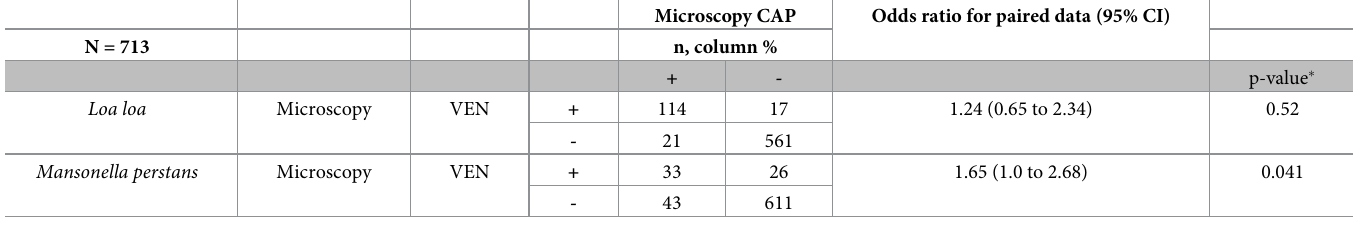
Table 4. Crosstabulation of capillary (CAP) and venous (VEN) microfilaraemia and odds ratios to quantify the odds to detect a microfilaraemia in CAP blood than in VEN